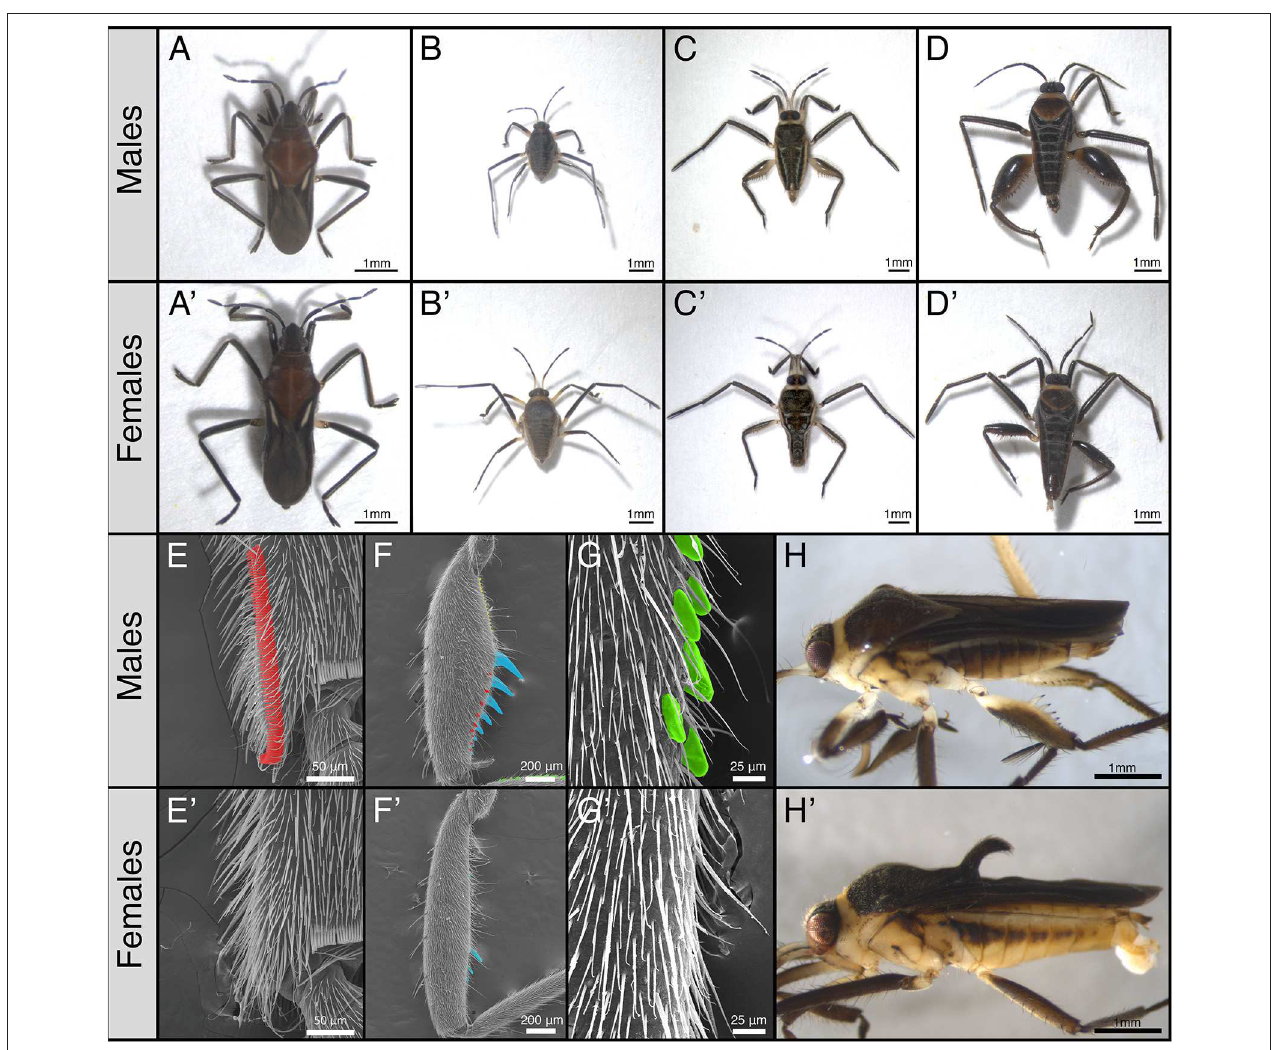
FIGURE 1 | Sexual dimorphism and secondary sexual traits in the genus Rhagovelia . The outgroup Oiovelia cunucunumana (A,A’) does not show strong dimorphism. In the genus Rhagovelia , sexual dimorphism can be subtle as in Rhagovelia plumbea (B,B’) or more extreme as in Rhagovelia antilleana (C,C’) or Rhagovelia sp.2 (D,D’) . This dimorphism affects secondary sexual traits such as the sex combs (in red) present in male fore-legs (E) and absent in females (E’) ; the presence of spikes (in blue, yellow and red) and the larger femur of the rear-leg femur in males (F) compared to females that only have some small femur spikes (F’) ; and the presence of spikes (in green) along the rear-leg tibia in males (G) that are also absent in females (G’) . Females possess secondary sexual traits such as a narrow abdomen (C’) and a pronotum projection (H’) that are absent in males (C,H)